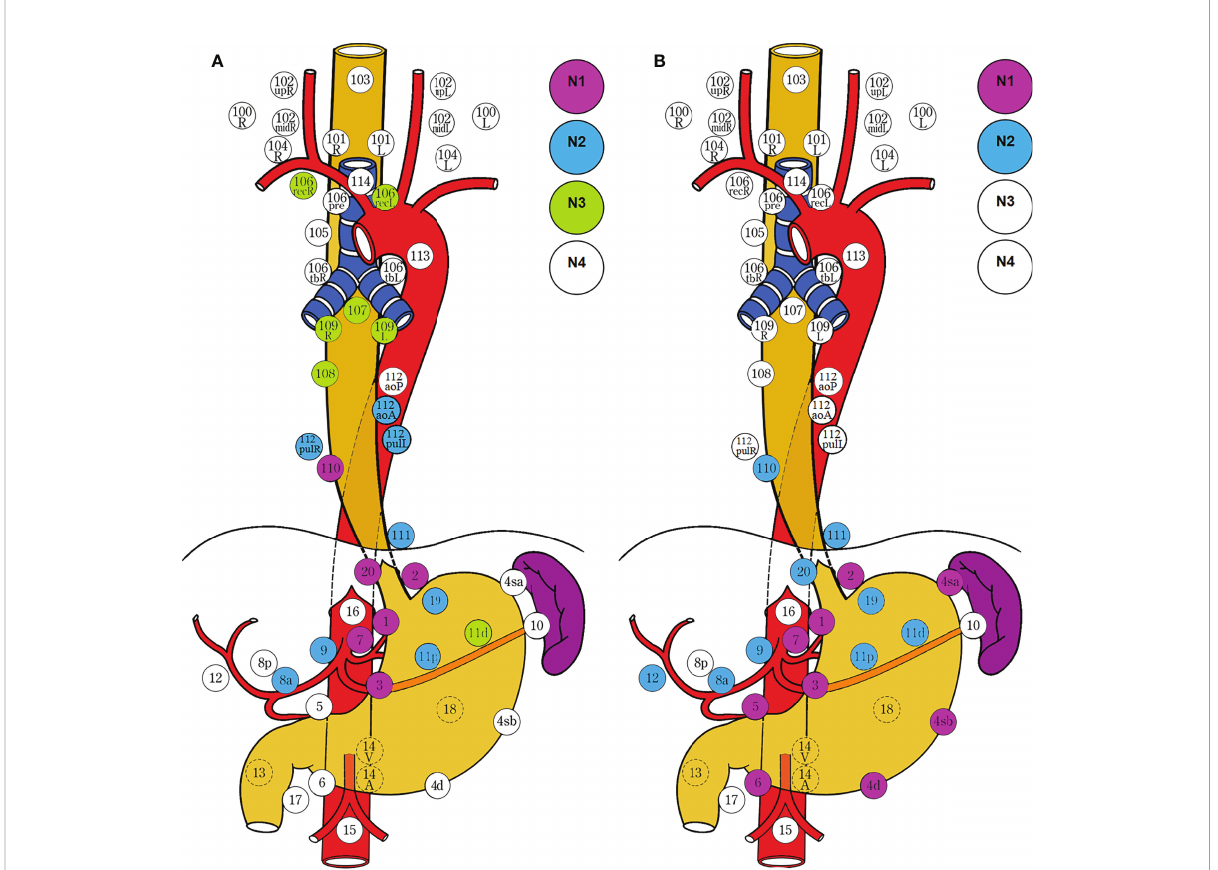
FIGURE 1 Lymph node dissection for EGJ cancer determined by the surgical approach. Two- fi eld D3 dissection via transthoracic esophagectomy was adopted by the Japanese Classi fi cation of Esophageal Cancer (11 th edition) (A) , and D2 dissection via transhiatal extended gastrectomy was employed by the Japanese Gastric Cancer Treatment Guidelines (5 th edition) (B) . The former ensures adequate proximal margin and complete mediastinal dissection, whereas the latter ensures extensive abdominal dissection and lower morbidity. The survivals are comparable between the two different procedures for dissection. N1, metastasis involving only group 1 lymph nodes; N2, metastasis to group 2 nodes, regardless of involvement of group 1 nodes; N3, metastasis to group 3 nodes, regardless of involvement of group 1 or 2 nodes; N4, metastasis to distant (group 4) nodes, regardless of whether any other group(s) of regional lymph nodes are involved or not. D1, complete dissection of N1 nodes, but no or incomplete dissection of N2 nodes. D2, complete dissection of N1 and N2 nodes, but no or incomplete dissection of N3 nodes. D3, complete dissection of N1, N2, and N3 nodes. The stations for dissection are marked with colored circles according to the grading of lymph node metastasis. The left side (L) and the right side (R) should be distinguished for 101, 102, 104, 106rec, 106tb, 109, and